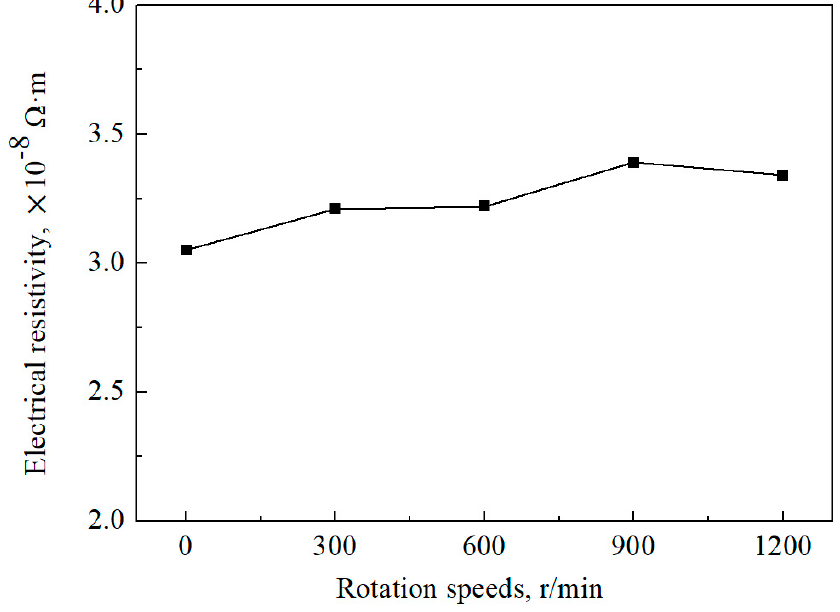
Figure 8. The electrical resistivity of the Ag–1.5Cu–1.0Y alloys under different rotation speeds.